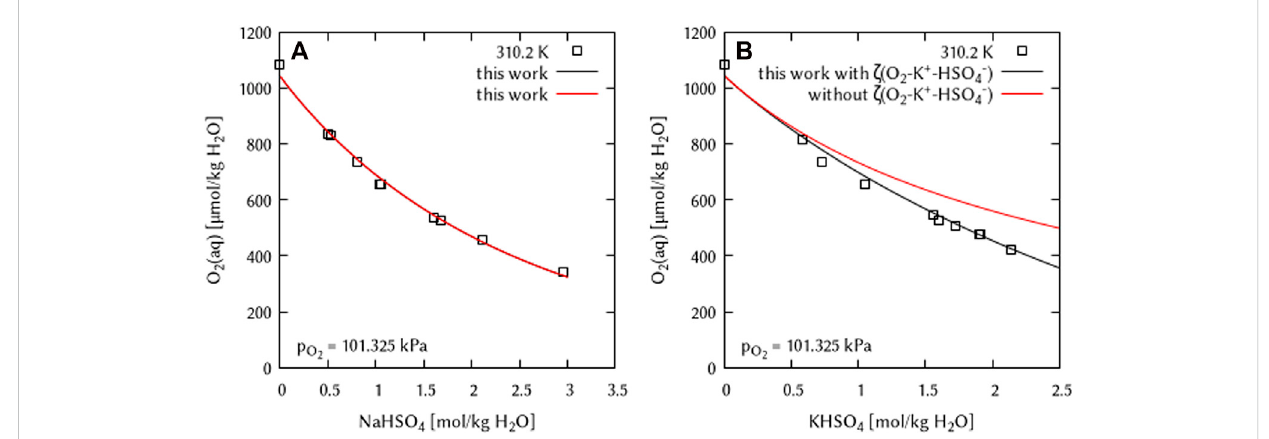
FIGURE 18 Modelling of the O 2 solubility in binary solutions of (A) NaHSO 4 , and (B) KHSO 4 as a function of electrolyte concentration at 310.2 K using the Pitzer coef fi cient set of this work. [Points: Experimental data from □ Lang and Zander (1986), Lines: this work].